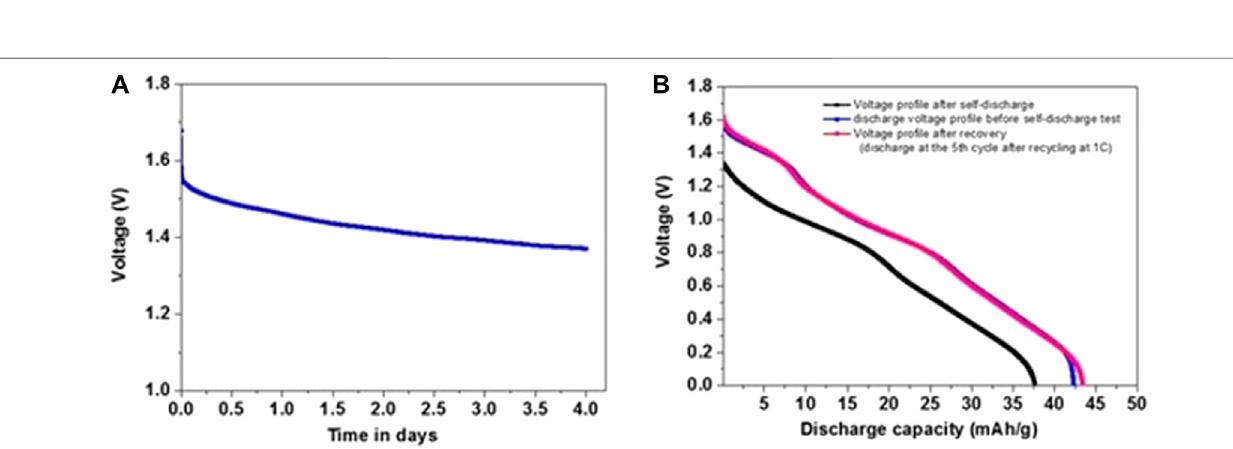
Frontiers in Energy Research |